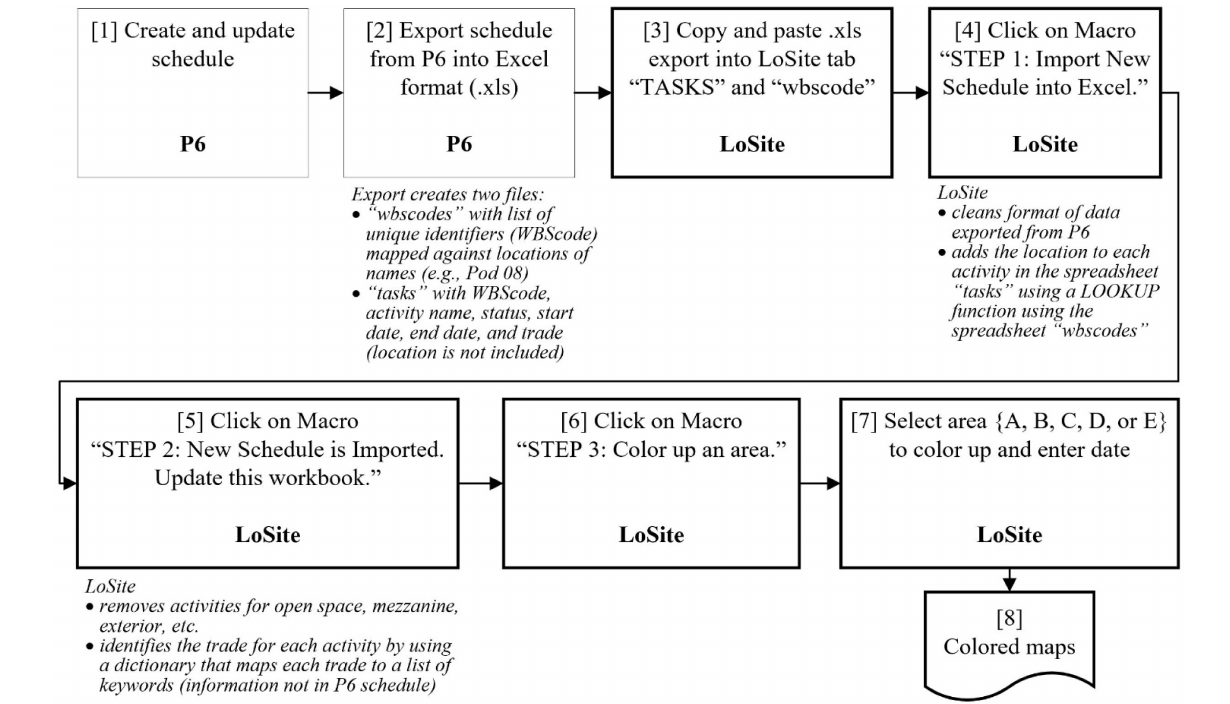
FIGURE 3 | LoSite program design